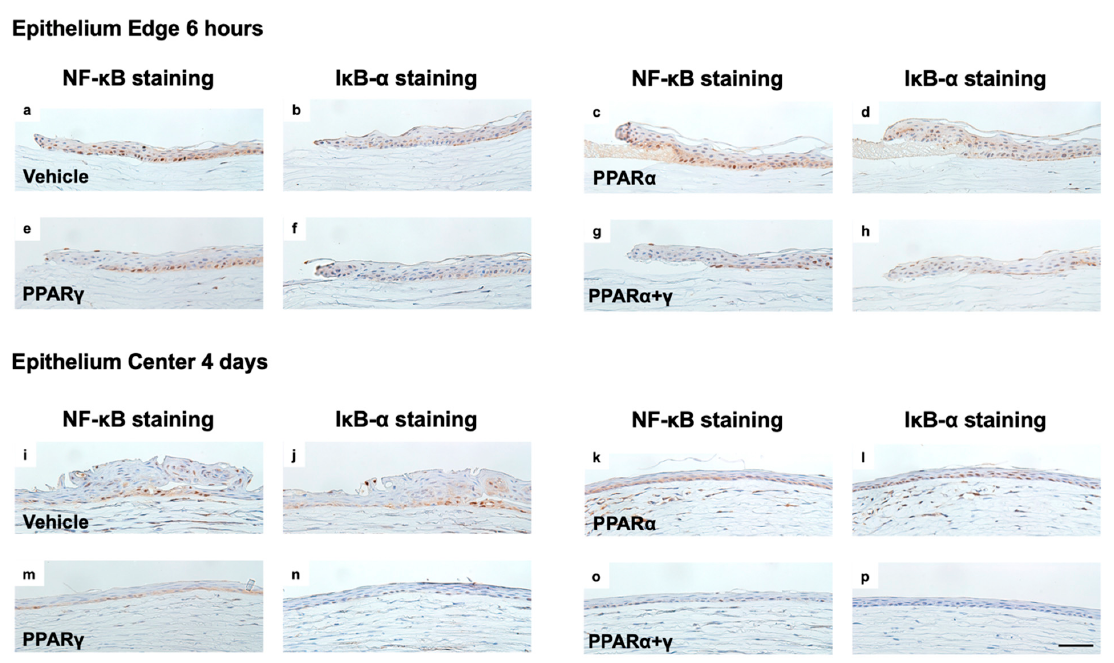
Figure 6. Immunostaining for NF- κ B and I κ B- α in epithelium cells in each group at 6 h and four days after the injury. Representative sections at 6 h ( a – h ) and four days ( i – p ) are shown. At 6 h after the injury, NF- κ B was strongly expressed in the cell nuclei in the vehicle group ( a ), whereas it was expressed at low levels in the nuclei in the PPAR α group ( c ). I κ B- α was expressed in the cytoplasm after PPAR α instillation ( d ). In the PPAR γ and PPAR α + γ groups, less NF- κ B expression was seen compared to the vehicle group and the PPAR α group ( e ), ( g ). The PPAR α + γ group exhibited a lesser degree of NF- κ B-positive inflammatory cell infiltration compared to the other three groups on day 4 after the injury ( i – p ). Bar, 50 μ m ( a – p ).